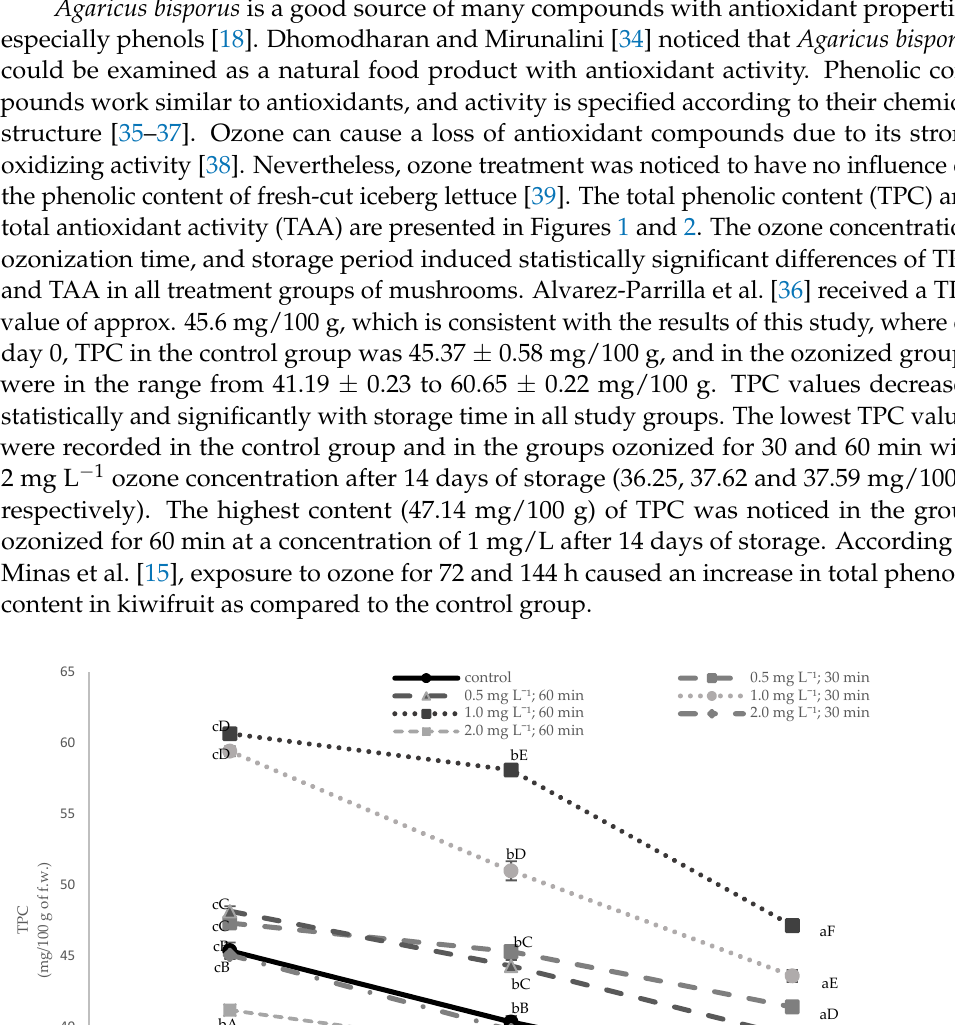
Figure 2. Effect of ozone dose, time of ozonization, and storage time on total antioxidant activity of Agaricus bisporus measured on 0, 7, and 14 days of storage at 2 °C. a–c: significant statistical differences for each treatment during storage time ( p < 0.05); A–D: significant statistical differences between treatments within each storage time ( p < 0.05). The values represent the mean ± standard error. In this research, DPPH reagent was used to neutralize free radicals. TTA values de- creased statistically and significantly with storage time in all study groups. At day 0, a control sample of mushrooms showed total antioxidant activity (TTA) at a level of 41.92 ± 0.53%; during the 7 and 14 days of storage, it decreased by 5.75% and 8.16%, respectively.